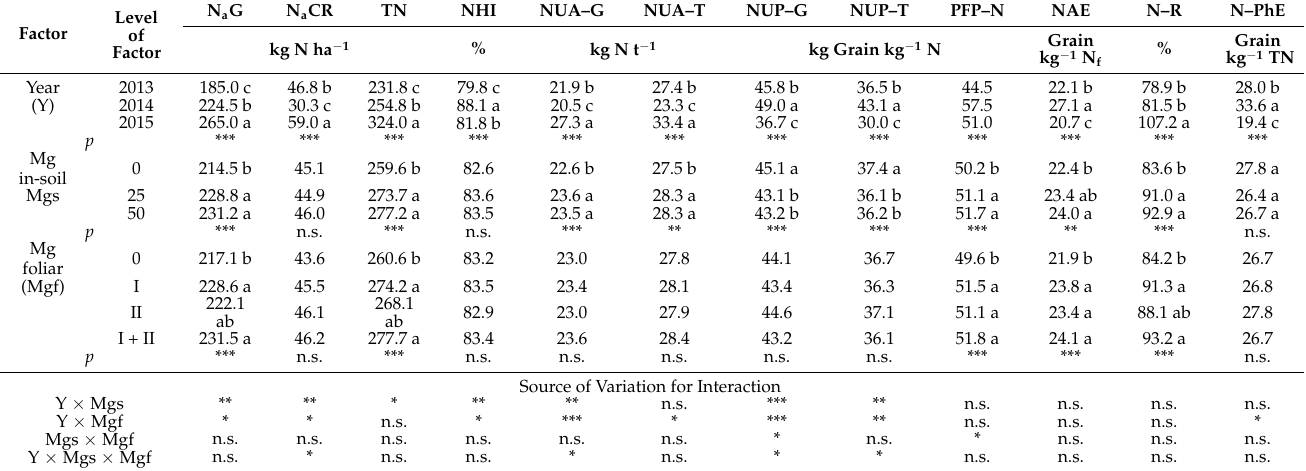
Table 2. Nitrogen uptake by winter wheat at maturity and indices of nitrogen use efficiency.